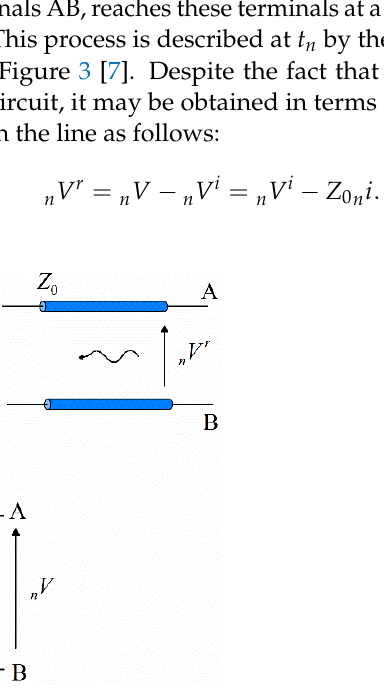
Figure 3. Thevenin equivalent circuit to describe the reflection process at terminals AB. The circuit is valid at t n , the moment in which the reflection occurs.